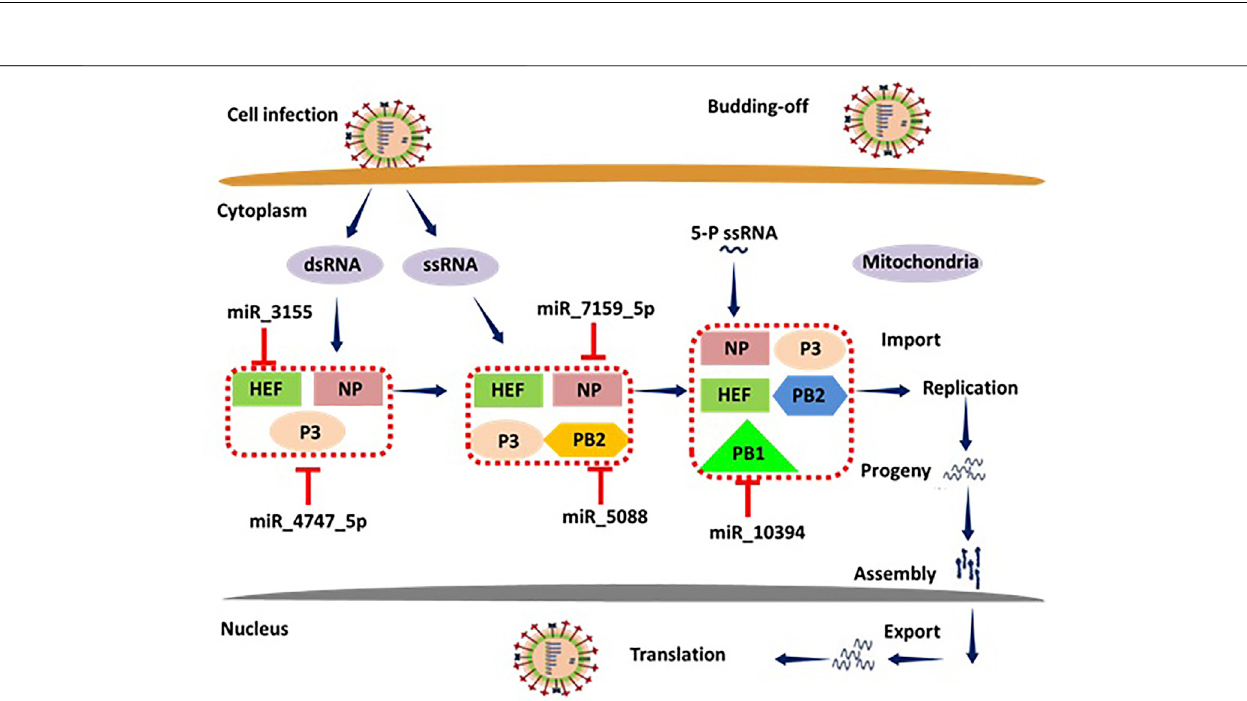
FIGURE 14 | Mechanistic pathway of miRNAs involvement in the immune response.